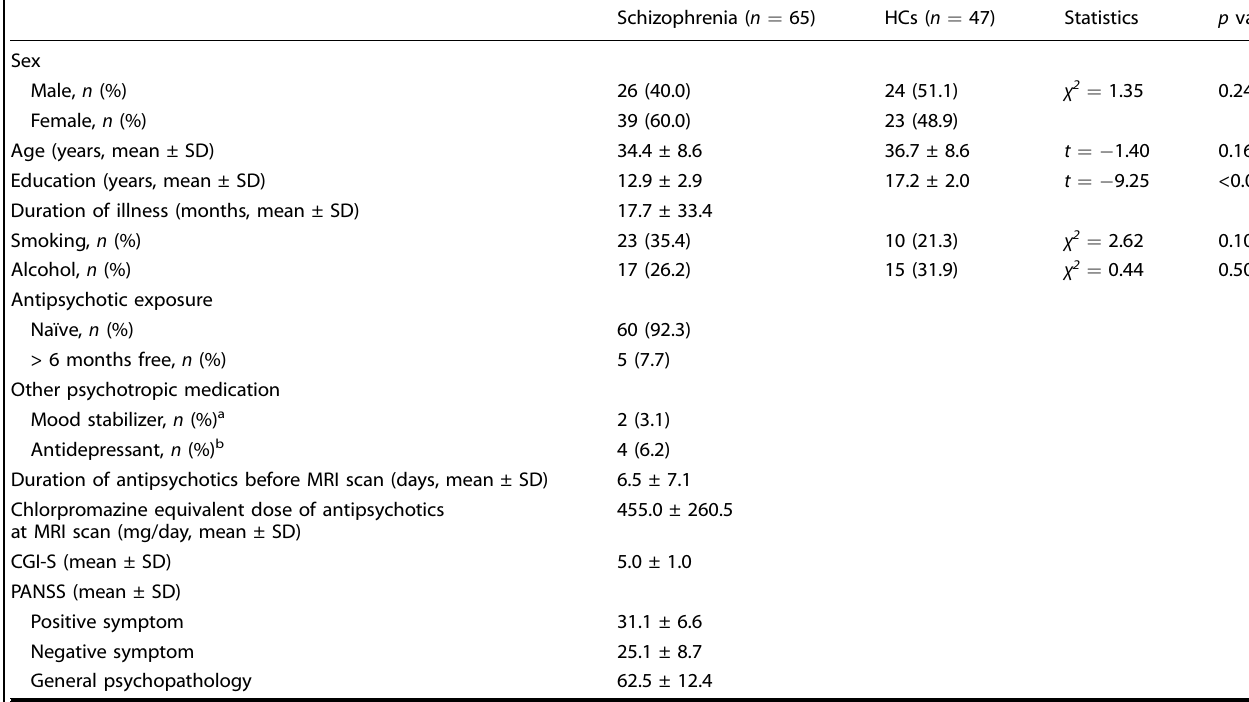
Table 1. Demographic and clinical characteristics of study